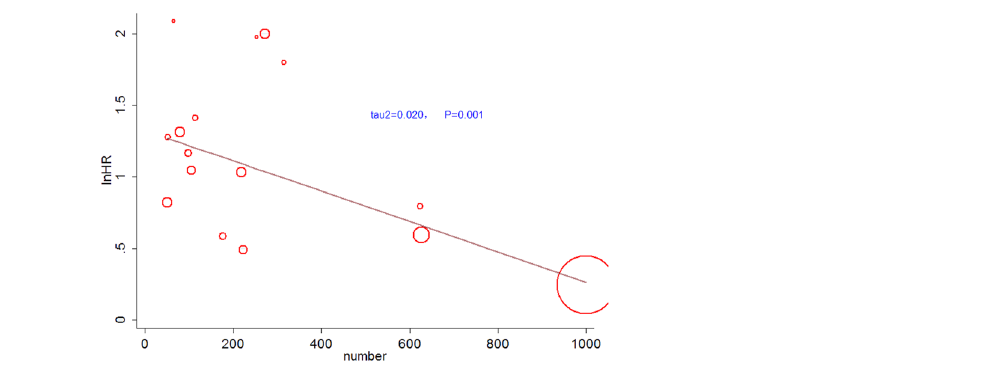
Figure 4. Meta-regression plot of HRs of OS against sample size.